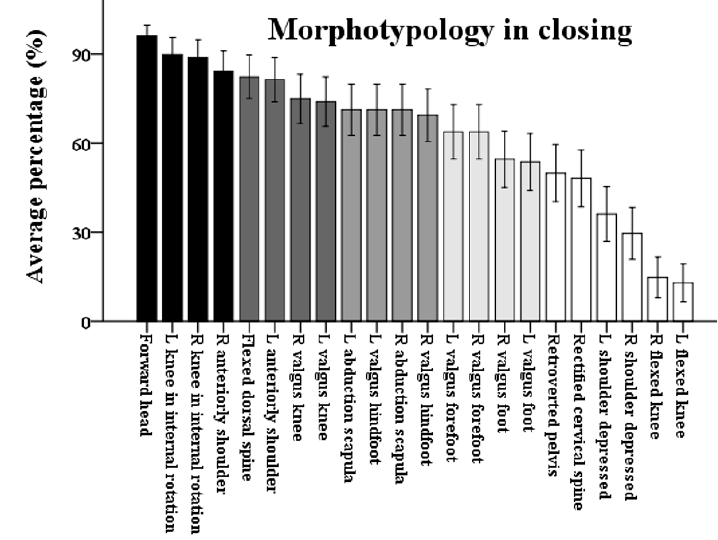
Figure 2. The average percentage of morphotype posture variables in closing. L = Left; R = Right.